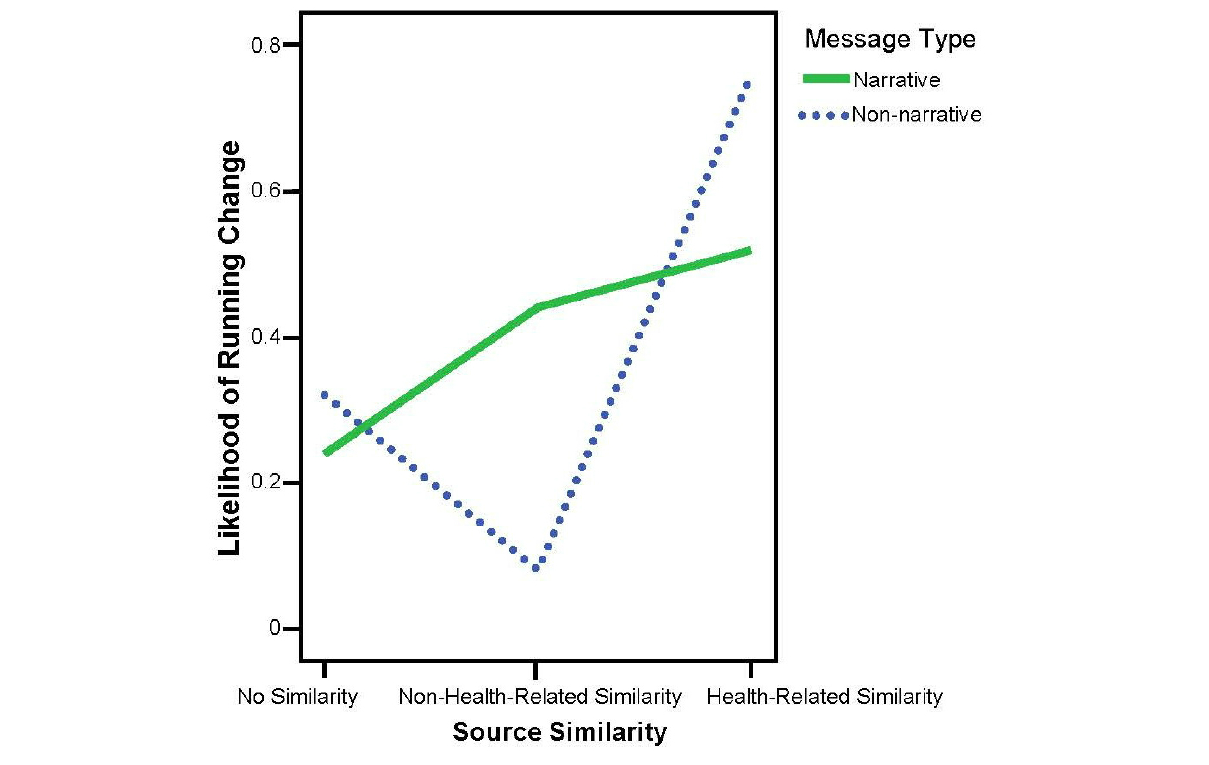
Figure 4. Interaction of message type and source similarity on likelihood of running